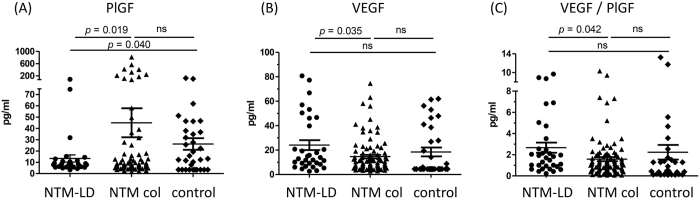
Plasma levels of (A) placenta growth factor (PlGF), (B) vascular endothelial growth factor (VEGF), and (C) their ratio according to nontuberculous mycobacteria (NTM)-lung disease (LD), pulmonary colonization (col), and control group. The cross lines are mean value and error bars are standard error of the mean. ns, not statistically significant.